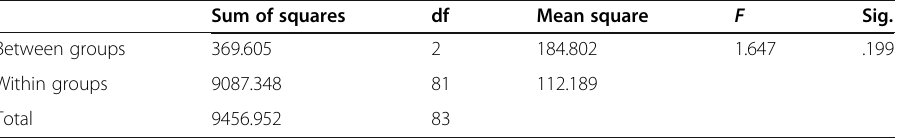
Table 5 Anova test results on student ’ s learning outcomes in understanding the knowledge about metacognitive strategy